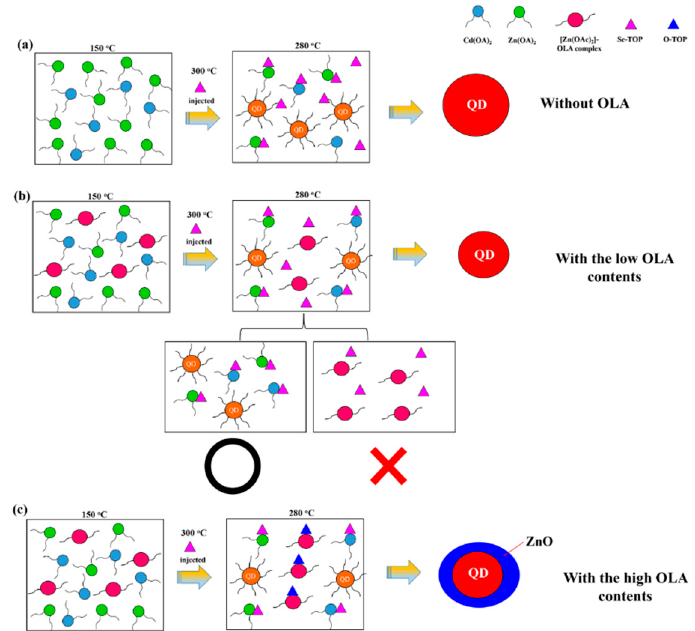
Figure 9. Schematic diagrams of the possible chemical reaction mechanisms underlying the one-pot chemical synthesis of Zn 0.5 Cd 0.5 Se alloy QDs ( a ) without OLA, ( b ) with low OLA contents, and ( c ) with high OLA contents.